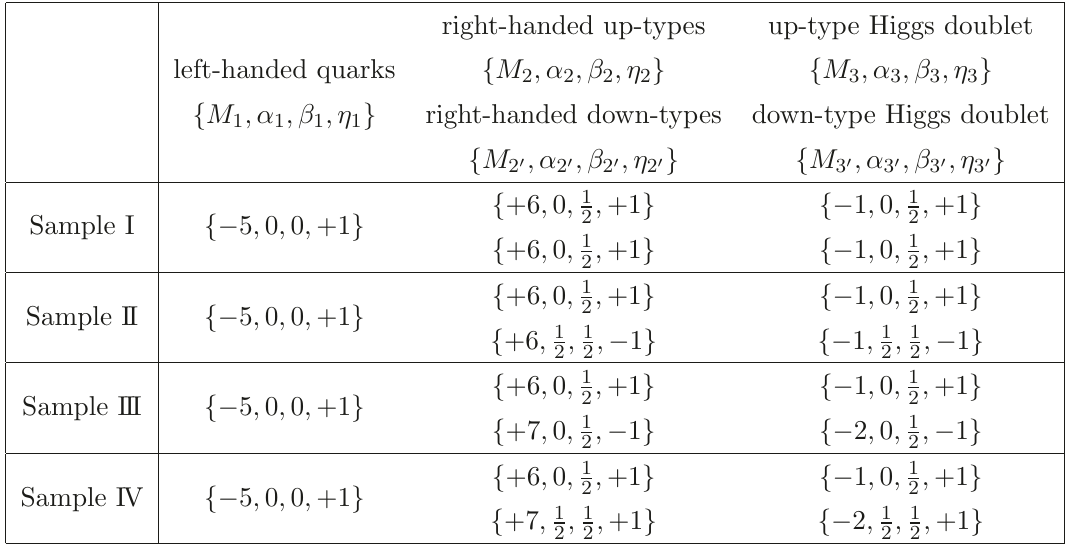
Table 1 . Sample patterns in proving an origin of the CP